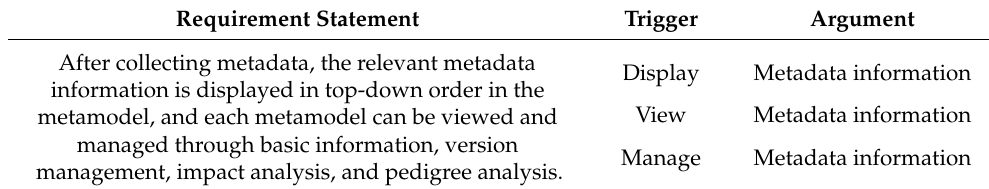
Table 2. Construction of argument dataset.